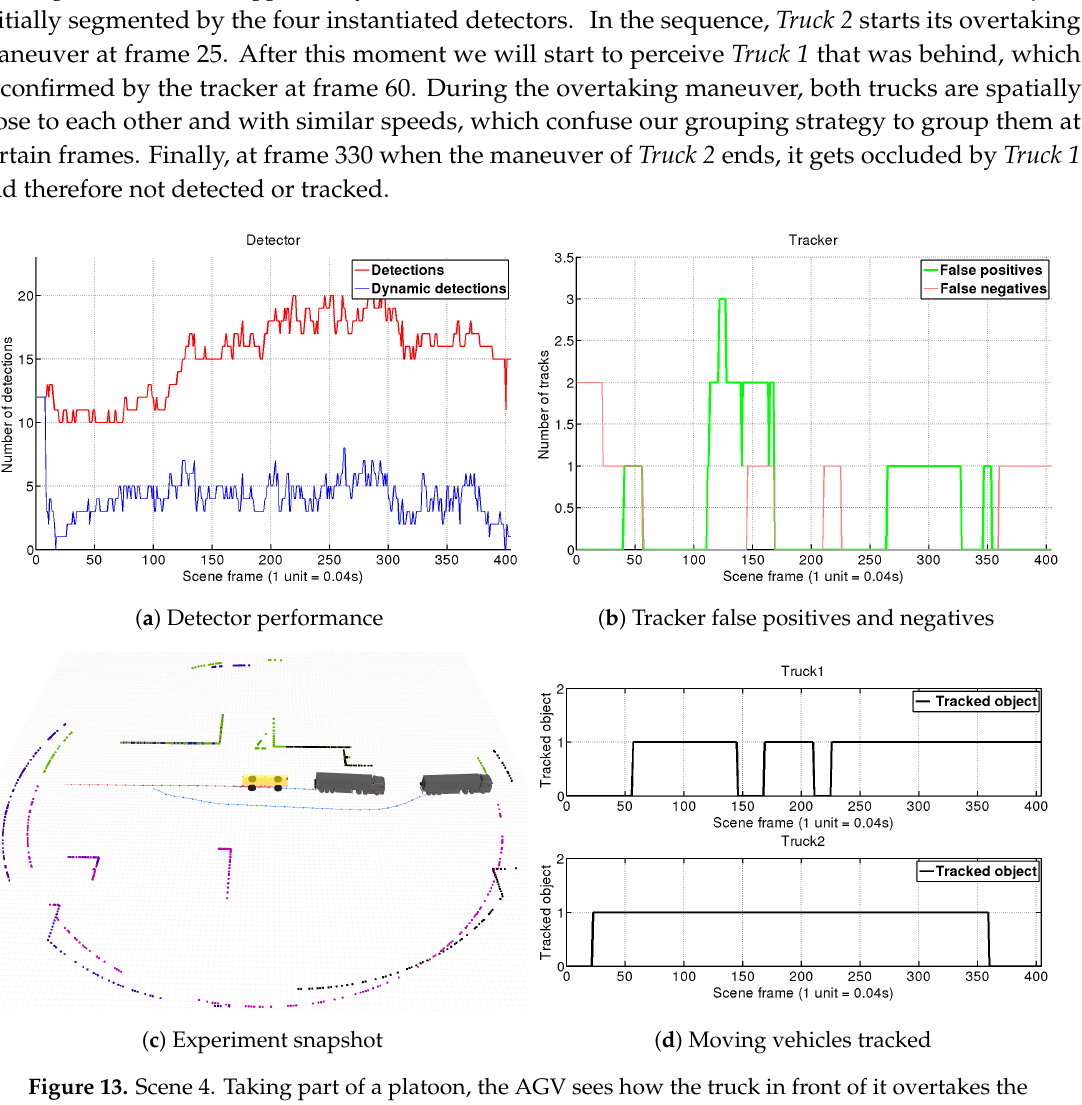
Figure 13. Scene 4. Taking part of a platoon, the AGV sees how the truck in front of it overtakes the head truck. It can be observed how in overtaking situations occluded vehicles become visible and the ones that were in sight get occluded, with the consequences that has to the DATMO